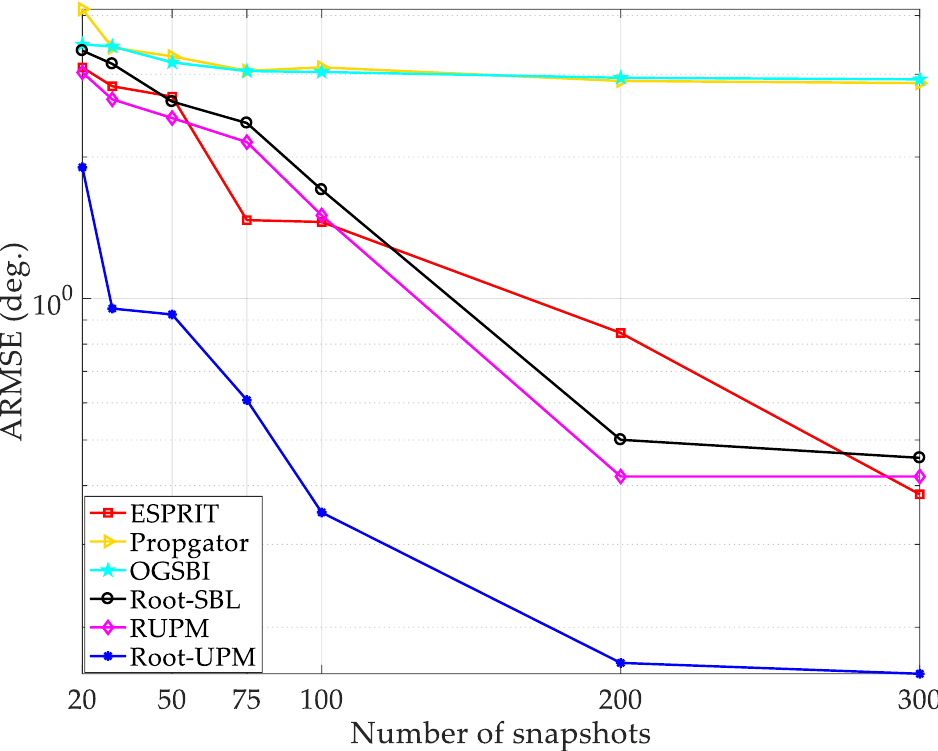
ff erent number of snapshots comparison of several AoA Figure 8. The ARMSE vs the different number of snapshots comparison of several AoA techniques. Figure 8. The ARMSE vs the di